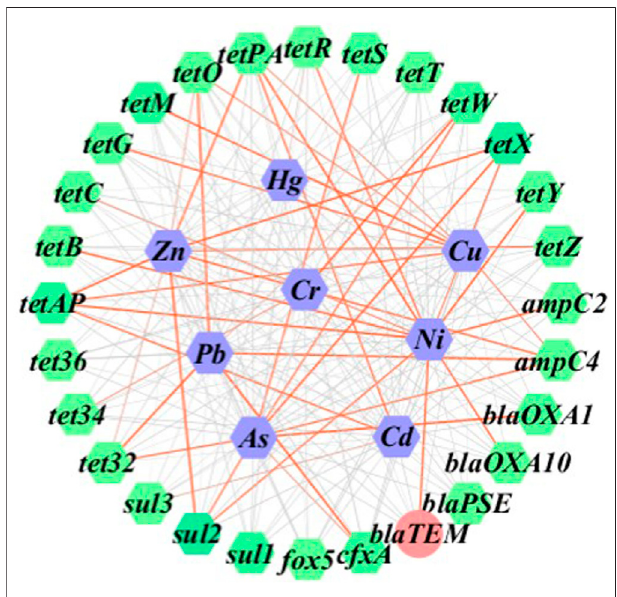
FIGURE 5 | Gene network image showing the correlations between ARGs and heavy metal elements across the 64 soil samples in total.